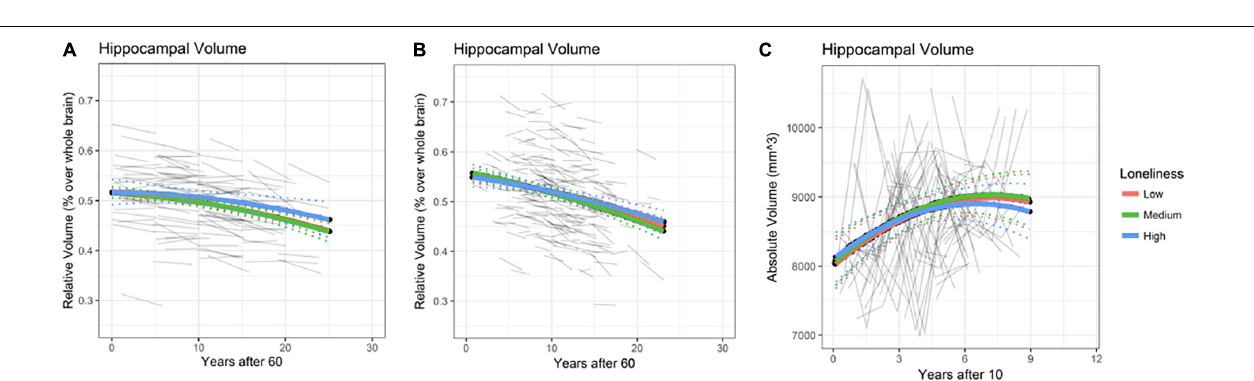
FIGURE 2 | Episodic memory predicted trajectories versus age after 60 for different loneliness levels for Betula (A) and BASE-II (B) . Association between loneliness and episodic memory change within the BETULA cohort: no effect was seen at age 60 (intercept), but from then onwards, medium and high loneliness scores were related to poorer memory performance over time. Dotted lines show 95% confidence interval for predictions with random effects set to 0.